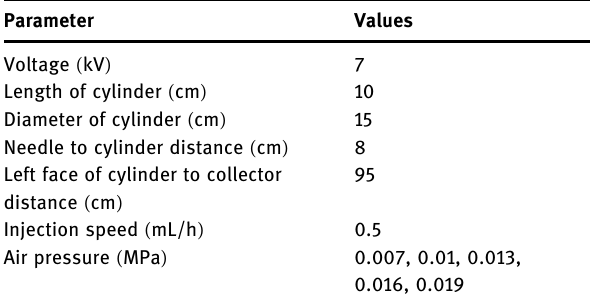
Table 1: Spinning conditions of di ff erent air pressures